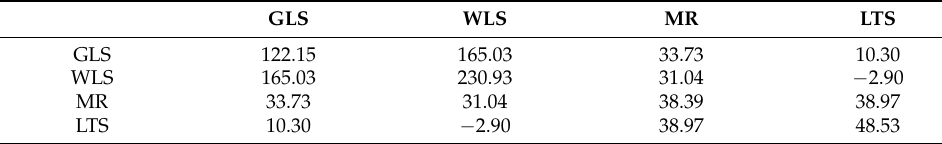
Table 6. Covariance matrix of the evaluation errors of the four